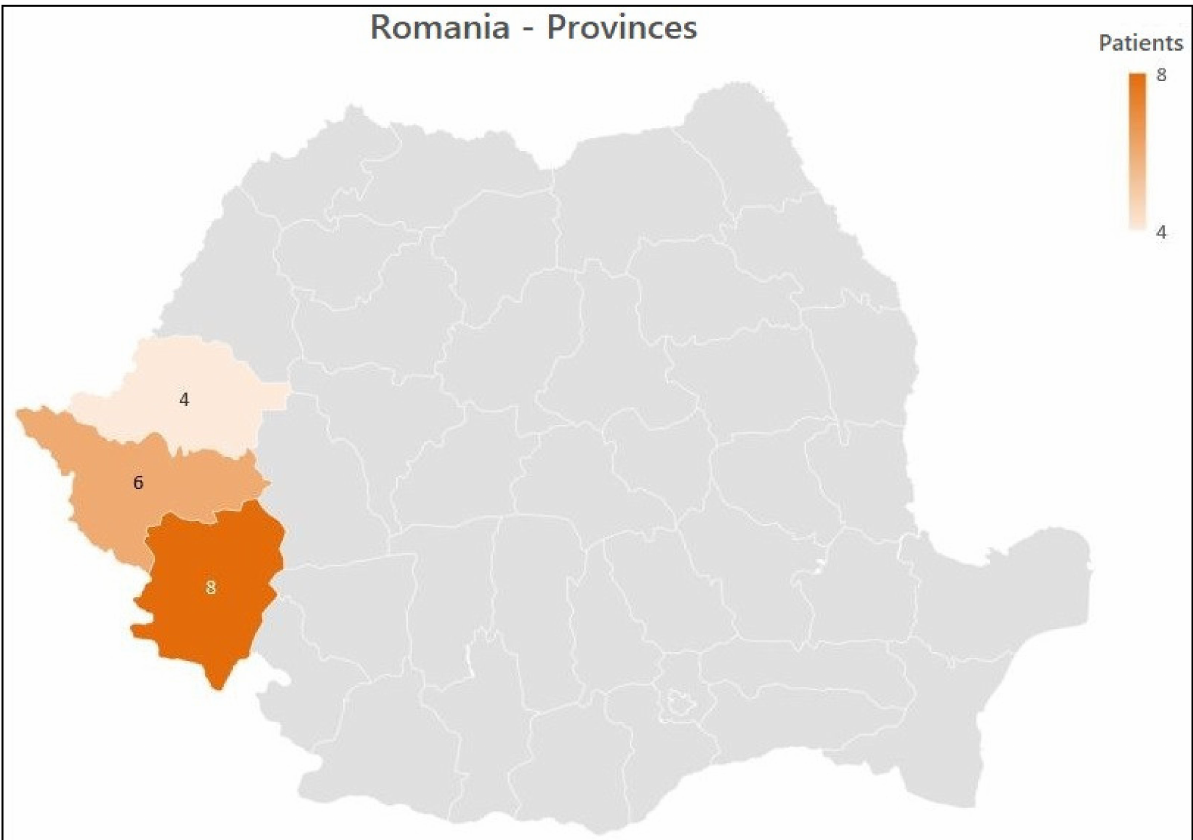
Figure 1. Yearly case frequency of foodborne botulism in Western Romania.